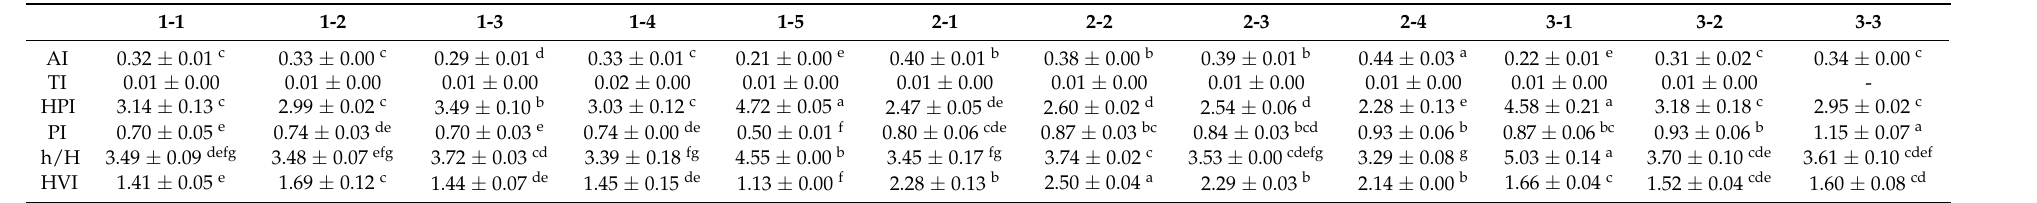
Table 10. Fatty acid evaluation indices of fresh sweet-waxy corn in the three regions.